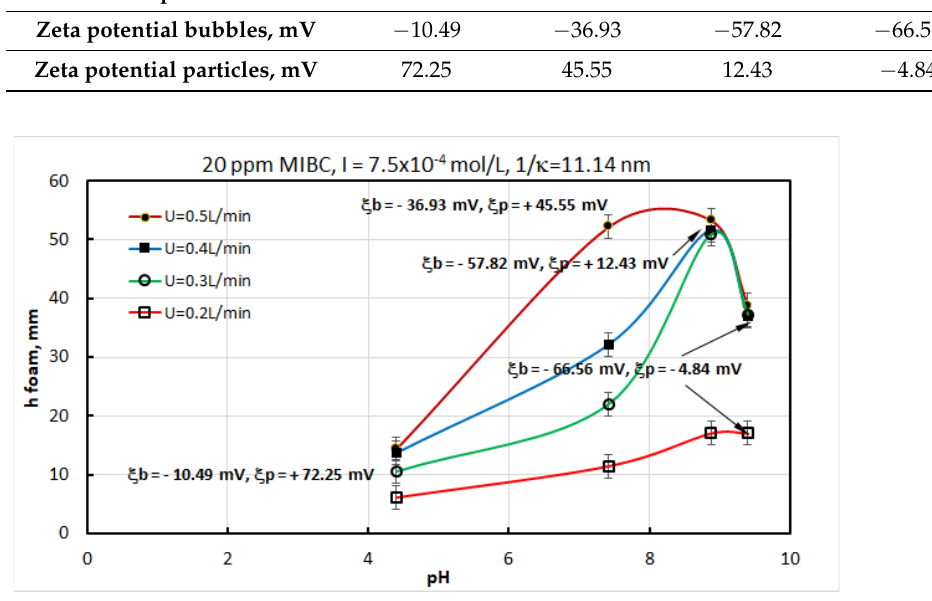
Figure 5. Height of the froth column of aqueous solution of 20 ppm MIBC + 1 wt.% modified fine silica particles vs. the pH value at constant ionic strength I = 7.5 × 10 − 4 mol/L at different gas delivery rates; the zeta potential of the bubbles at each pH value is depicted in the figure. The error bar is ± 2 mm.